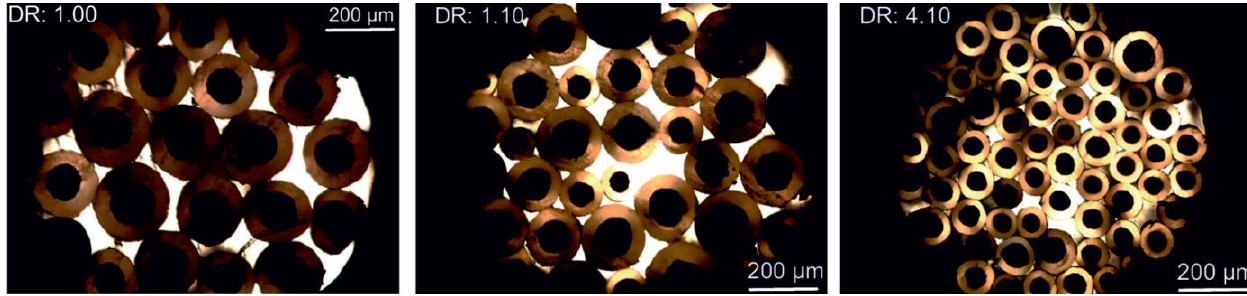
Figure 11. Optical bright field microscopy images for different draw ratios. The fibers’ center is dark, the PVDF sheath is